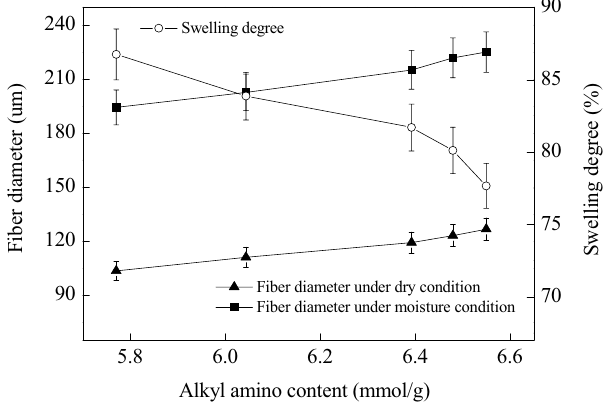
Figure 9. Diameter and swelling degree of PP-AM-HBP-NH 2 .